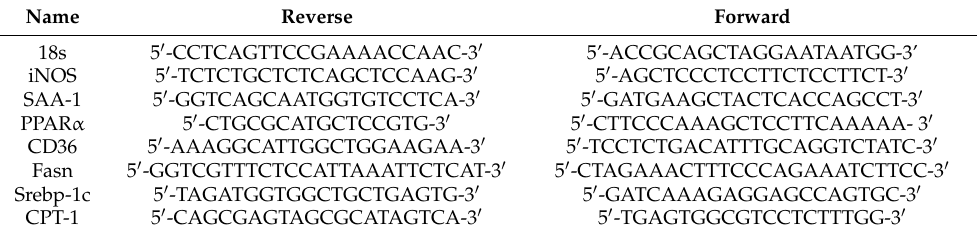
Table 2. Sequences of the primers used for quantitative real-time PCR.